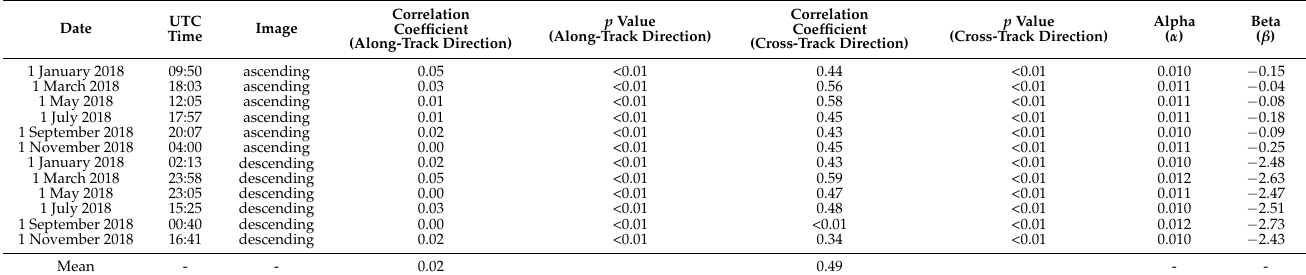
and d c ). Colored scatters are i , j i , j , e c and the distance d a , d c in the i , j i , j i , j i , j